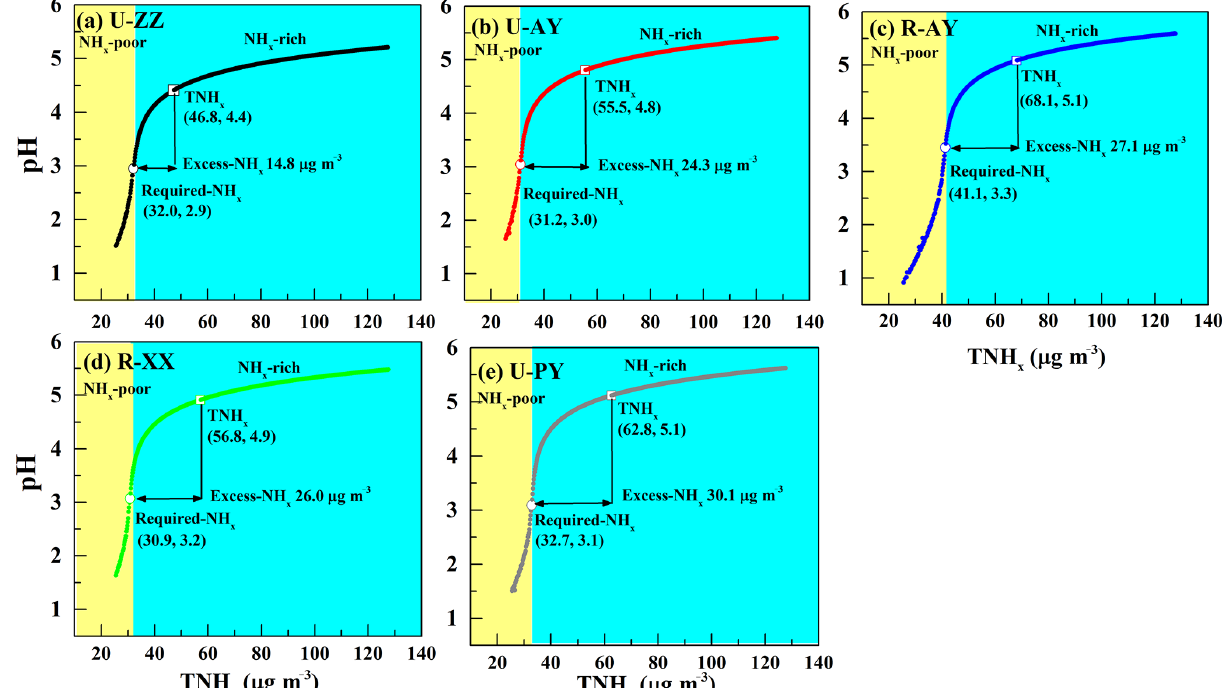
Figure 7. (a–e) Particle pH corresponds to increasing T NH x at the five sites, used to examine the effects of major indicators of NH 3 (i.e., T NH x , Required-NH x , and Excess-NH x ) on aerosol acidity. Particle pH was calculated by using a wide range of T NH x (25–130µgm − 3 ) and average values of other parameters during Case 2 of each site. The concentrations of T NH x , Required-NH x , and Excess-NH x with corresponding pH values are marked by a hollow box, hollow circle, and arrow, respectively. The yellow and blue background colors correspond to the NH x -poor and NH x -rich regions,